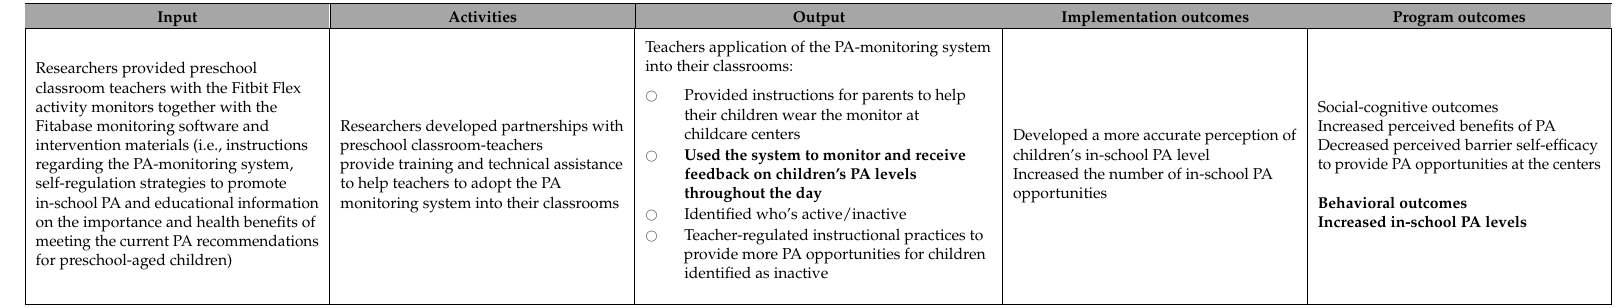
Figure 2. Logic model depicting the theory of change. Due to time and resources constraints, only indicators in bold-face were measured in the current